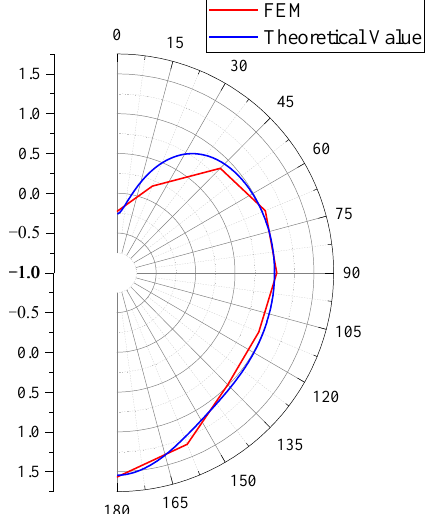
Figure 16. Circumferential stress distribution. The black line in the figure indicates the position of the coordinate axis with zero stress. The compressive stress is inside the coordinate axis, and the tensile stress is outside the coordinate axis. The maximum compressive and tensile stresses obtained by theoret- ical calculation are − 1.26 MPa and 0.54 MPa, respectively; the finite element results are − 1.23 MPa and 0.56 MPa, respectively. The difference between the theoretical method and method in calculating the concrete